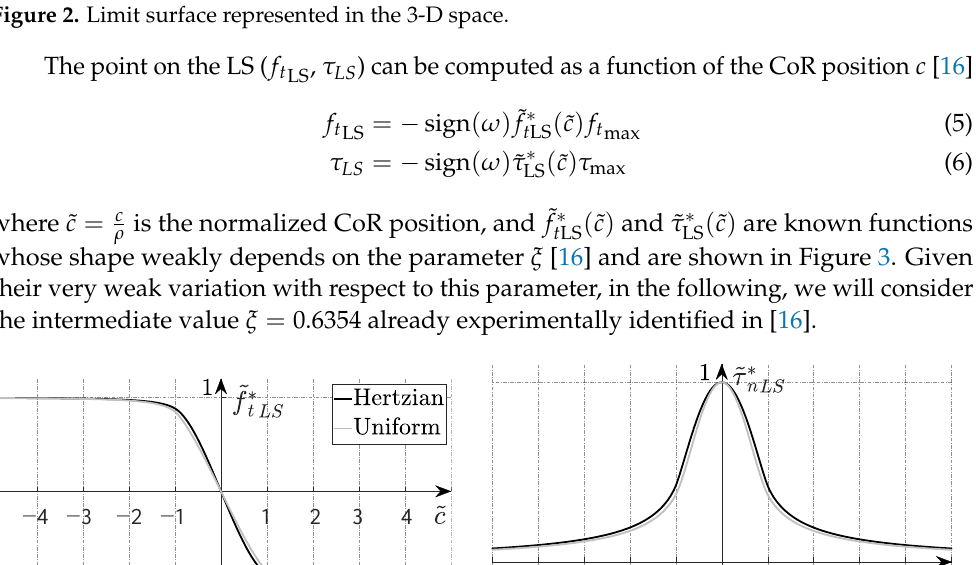
Figure 3. Graph of the functions ˜ f ∗ tion